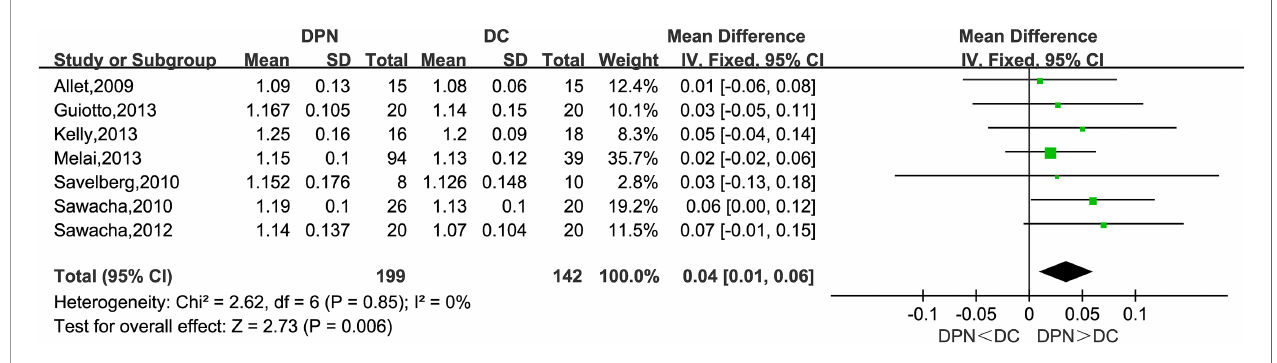
FIGURE 5 | Forest plot of stride time(s).